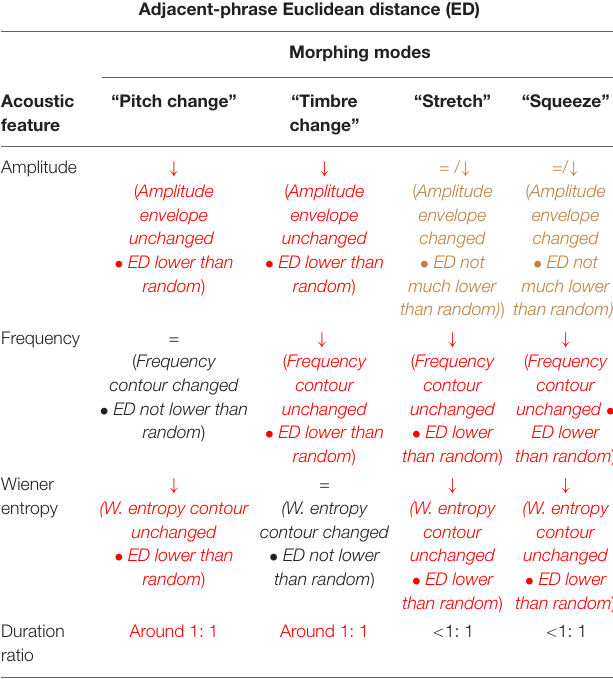
TABLE 2 | How the four morphing modes would affect the expected syllable similarity between adjacent phrases. Adjacent-phrase Euclidean distance